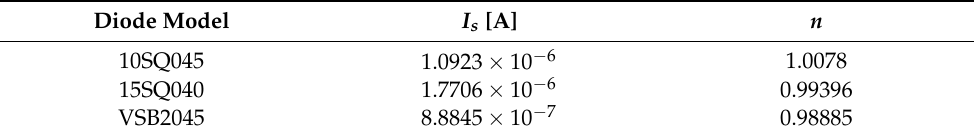
Table 5. Forward bias ( D f ) curve fitting parameters for the three diodes.